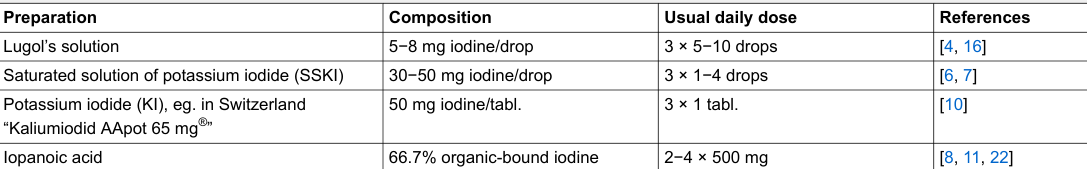
Table 1 : An overview of oral iodine-containing preparations administered preoperatively to patients with Graves’ disease. Preparation Composition Usual daily